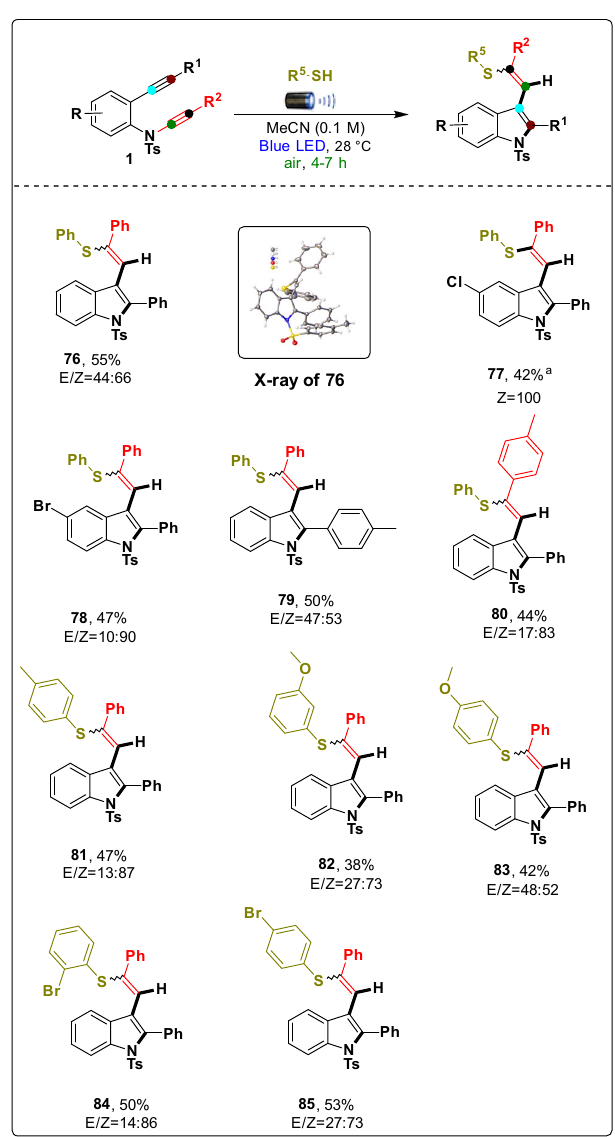
Fig. 6 Substrate scope of 2-alkynyl-ynamides and aromatic thiols. Reaction conditions: 2-alkynyl-ynamides 1 (0.1 mmol), aromatic thiol (0.25 mmol), and MeCN (0.1 M) were stirred at 28 °C under irradiation with a 40 W Kessil blue LED for 4 – 7 h in air; isolated yields of the mixture of E and Z isomers were reported, and E / Z ratios were determined based on alkene protons in 1 HNMR. a Z isomer was